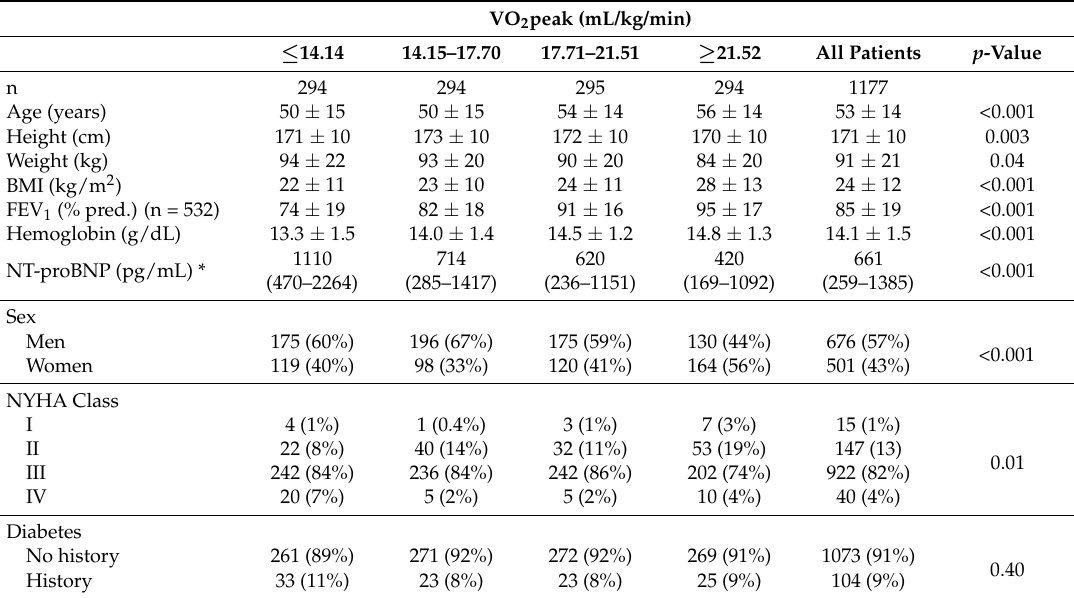
Table 1. Characteristics of the study